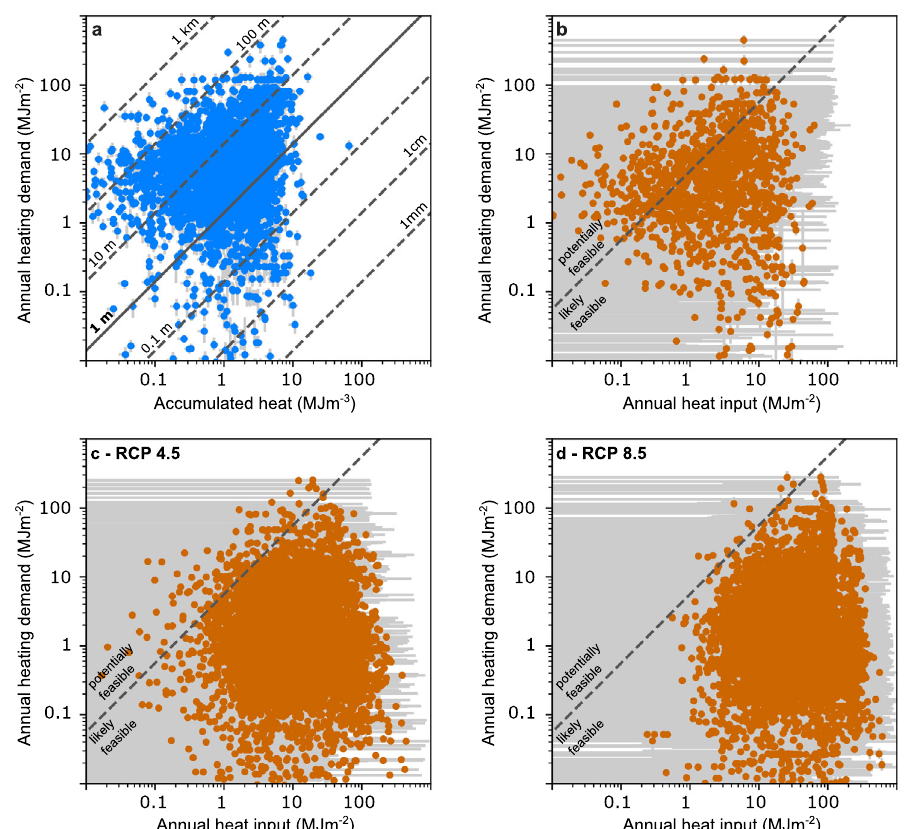
Fig. 3 Feasibility of subsurface heat recycling under all scenarios. Please note: for all parts of this fi gure only locations with unconsolidated sediments are shown. a Comparison of accumulated heat of the status quo and annual heating demand. The diagonal contour lines indicate the extraction length necessary to generate one year of heat when recycling the accumulated heat. (Note that locations with no heating demand or no accumulated heat are not shown). Comparison of annual mean heat input and heating demand for the recycled scenario ( b ), and the scenario climate change with RCP 4.5 (coupled with the shared socioeconomic pathway (SSP) 2 ( c ), and RCP 8.5 (coupled with SSP 5, d ). The diagonal line separates likely feasible locations (i.e., the generated heat is more than 25% of the annual heating demand) from potentially feasible locations (i.e., the generated heat is less than 25% of the annual heating demand). (Note that locations with no heating demand or no heat input are not